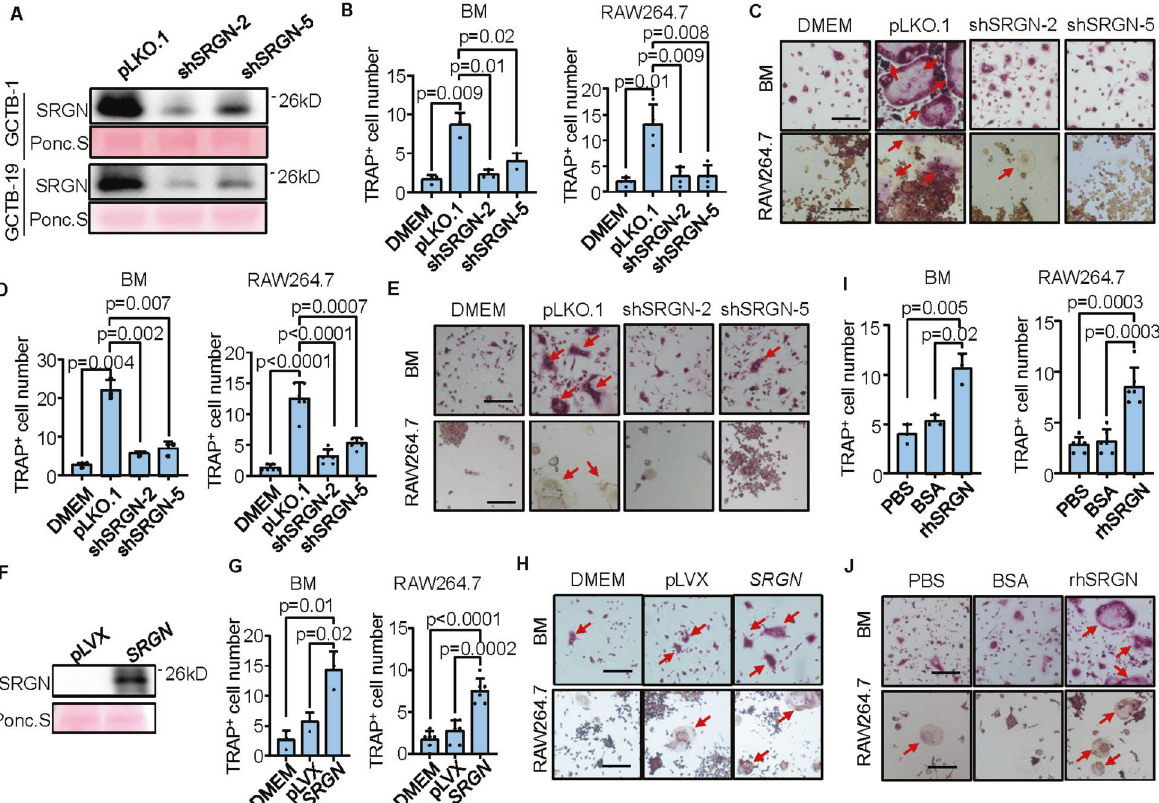
Fig. 2 SRN promotes osteoclastogenesis in vitro. A Western blotting analysis to validate SRGN knockdown in GCTB-1 and GCTB-19. B , C Osteoclast quanti fi cation ( B ) and representative images ( C ) in mouse primary bone marrow (BM) and RAW264.7 cultured in DMEM medium or conditioned media (CM) of GCTB-1 with or without SRGN knockdown in osteoclastogenesis assays. D , E Osteoclast quanti fi cation ( D ) and representative images ( E ) in mouse primary bone marrow and RAW264.7 cultured in DMEM medium or CM of GCTB-19 with or without SRGN knockdown in osteoclastogenesis assays. F Western blotting analysis to validate SRGN overexpression in hFOB1.19. G , H Osteoclast quanti fi cation ( G ) and representative images ( H ) in mouse primary bone marrow and RAW264.7 cultured in DMEM medium or CM of hFOB1.19 with or without SRGN overexpression in osteoclastogenesis assays. I , J Osteoclast quanti fi cation ( I ) and representative images ( J ) in mouse primary bone marrow and RAW264.7 treated with or without human recombinant SRGN protein (25 ng/mL) in osteoclastogenesis assays. Scale bar, 100 μ m. Arrows point to giant osteoclast cells ( C , E , H , J ). P values were obtained by two-tailed unpaired t test ( B , D , G , I ). Bar graphs are shown as mean ±